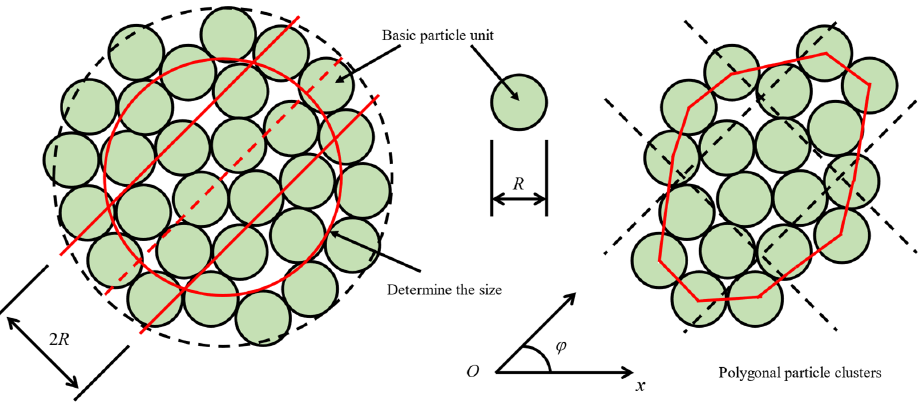
Figure 10. Basic unit and polygon particle